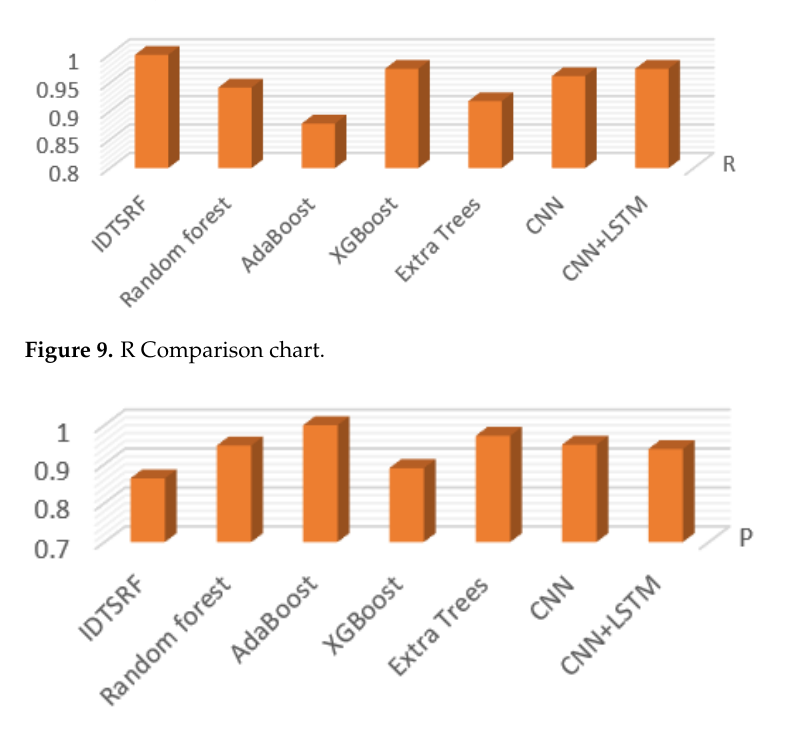
Figure 10. P Comparison chart.